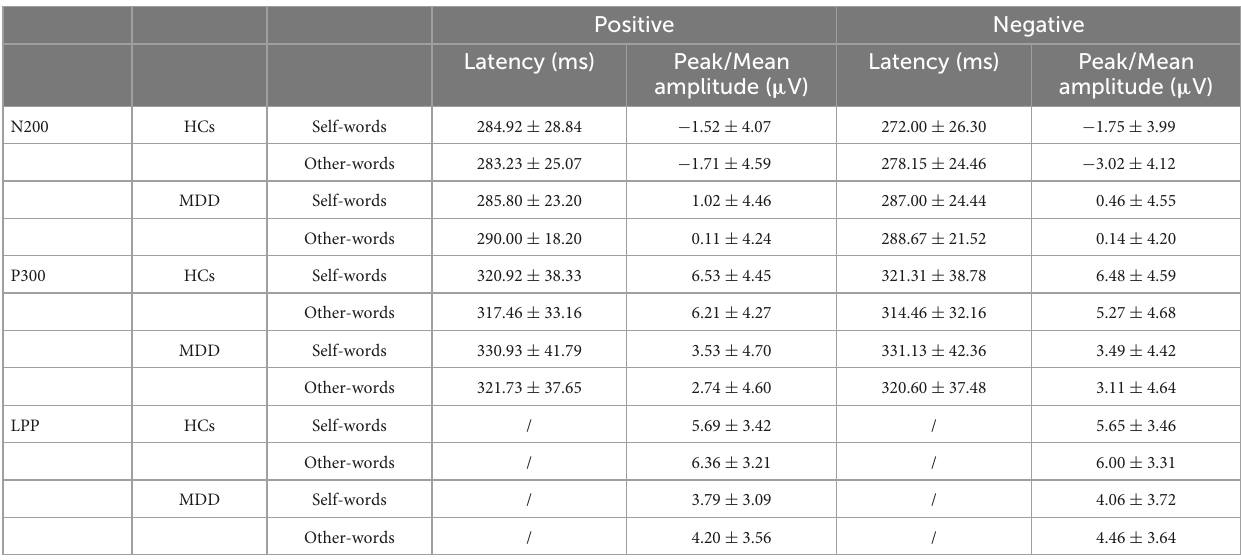
TABLE 3 The N200, P300, and LPP of MDD and HCs in EAST (M ± SD).